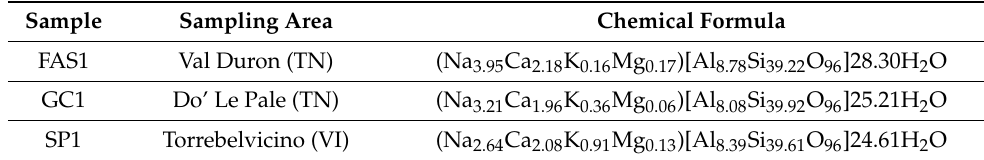
Table 3. Chemical formula of the studied mordenite